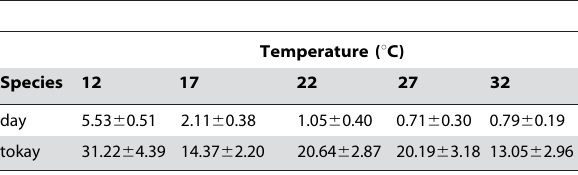
Table 2. Average maximal adjusted adhesive force (N) by species and temperature. Errors are 6 1 SEM.